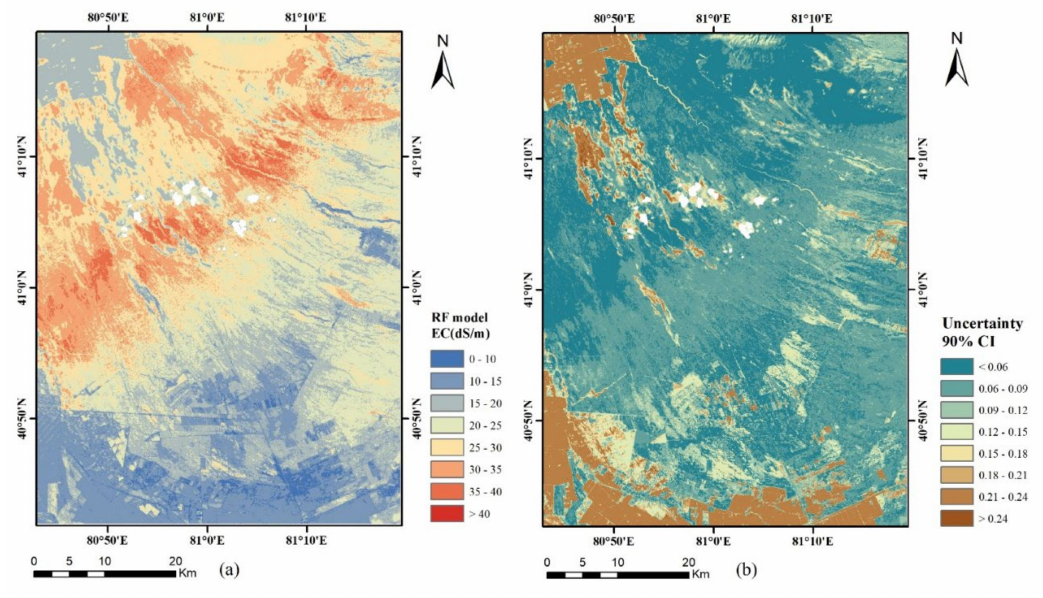
Figure 5. EC map derived from random forest model ( a ) and uncertainty map of soil EC values ( b